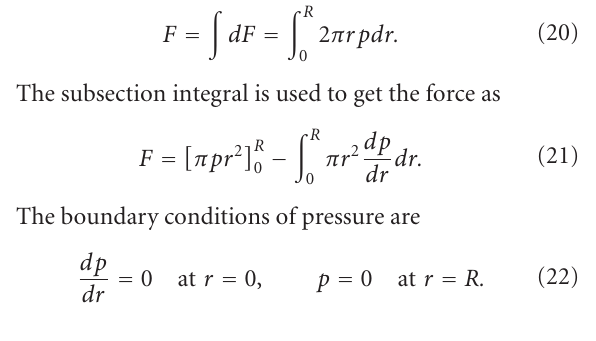
100 kAmp/m by solving (16) and (19). The absolute value of the pressure gradient increases with the radius in linear,